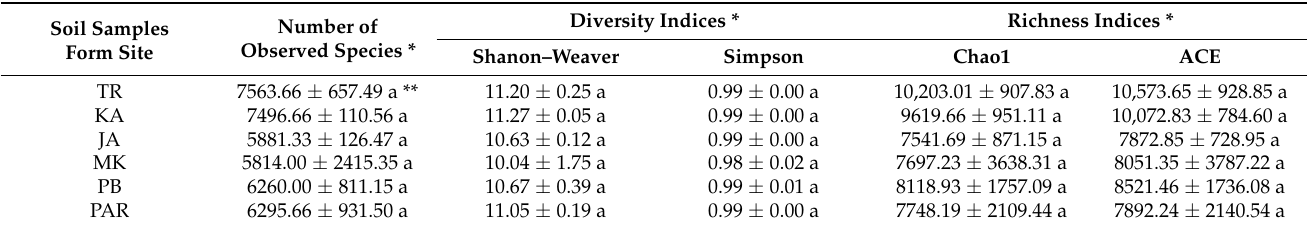
Table 4. Indices of bacterial diversity and richness of mangrove soil from each sampling